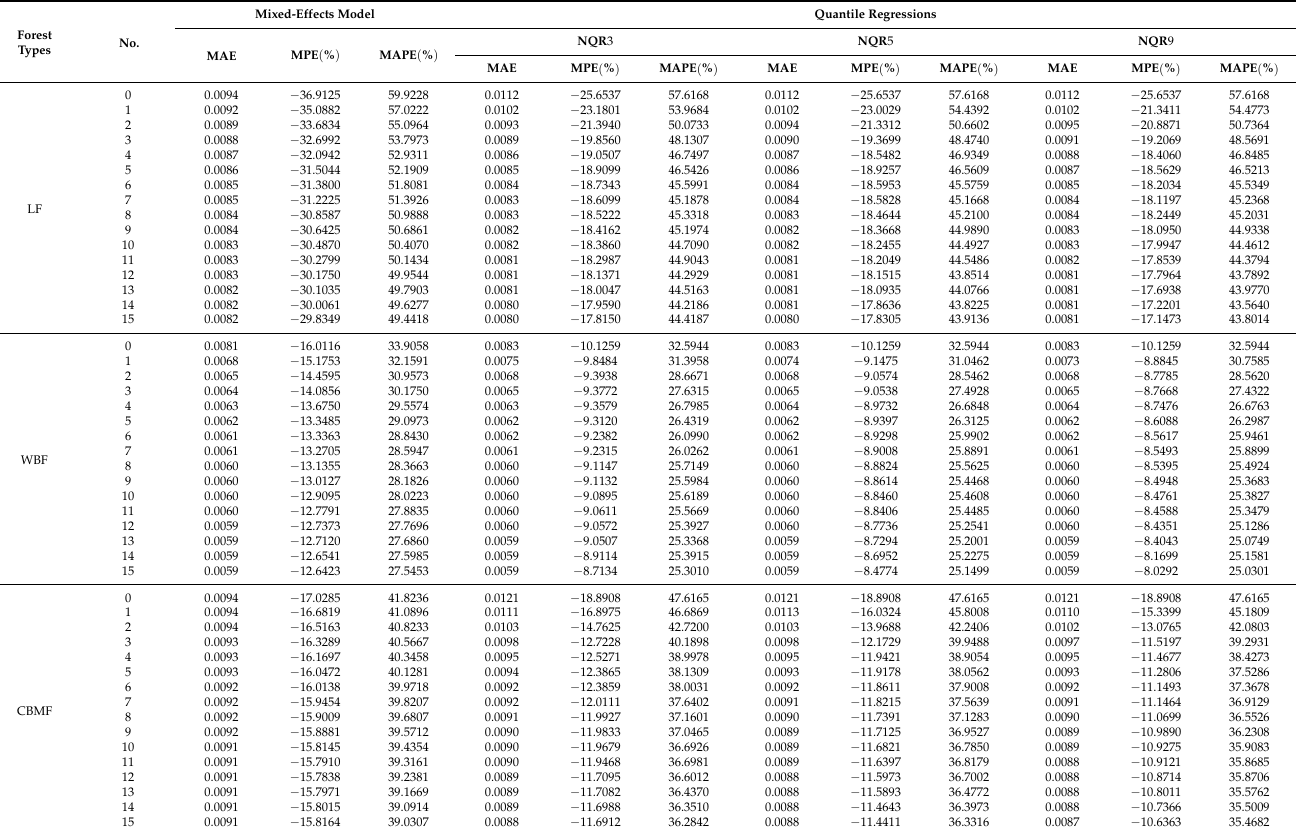
Table A7. Evaluation statistics of the mixed-effects, NQR9, NQR5, and NQR3 regression models for the RGR nv across 0–15 random sampling strategies for LF, WBF, and